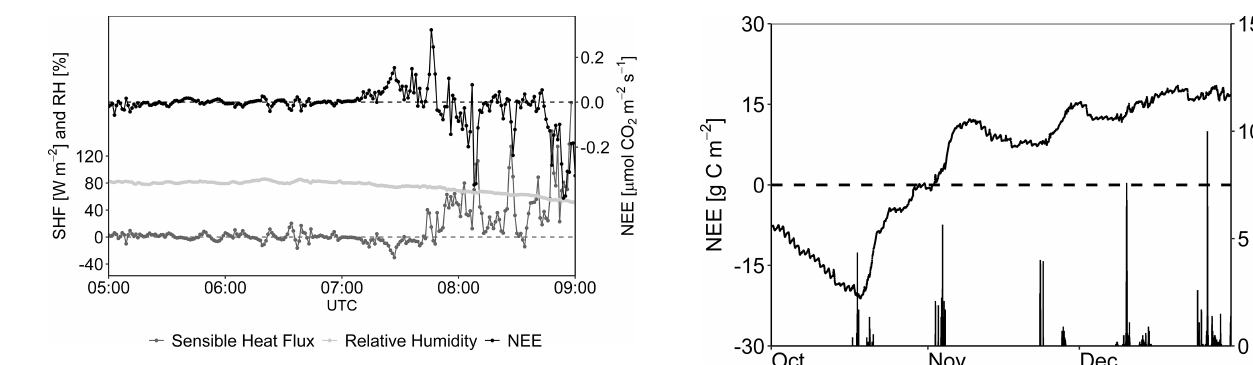
Figure 10. Cumulative NEE fluxes and 30min rainfall during the initial window of disturbance, from 1 October to 31 December